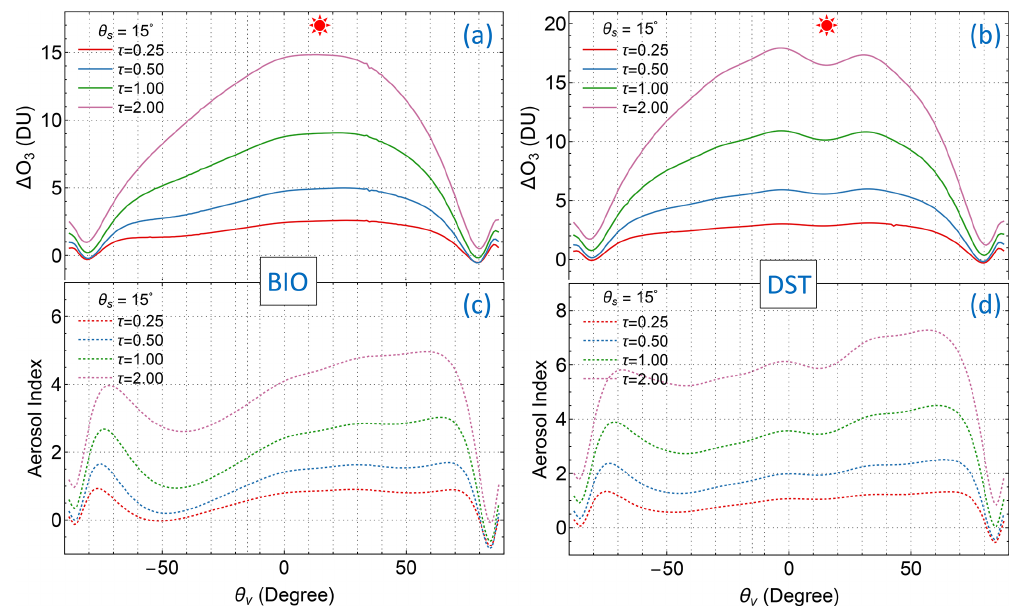
Figure 22. Errors in retrieved O 3 due to MLER treatment of two common UV-absorbing aerosols, (a) BIO ( ω = 0 . 921) and (b) DST ( ω = 0 . 900), with various optical thicknesses ( τ = 0.25, 0.5, 1.0, and 2.0 at 340nm) located at 5km altitude. See the Fig. 4 caption for the specification of viewing and illumination geometry. The AIs associated with each observation scenario are shown in (c) and (d)